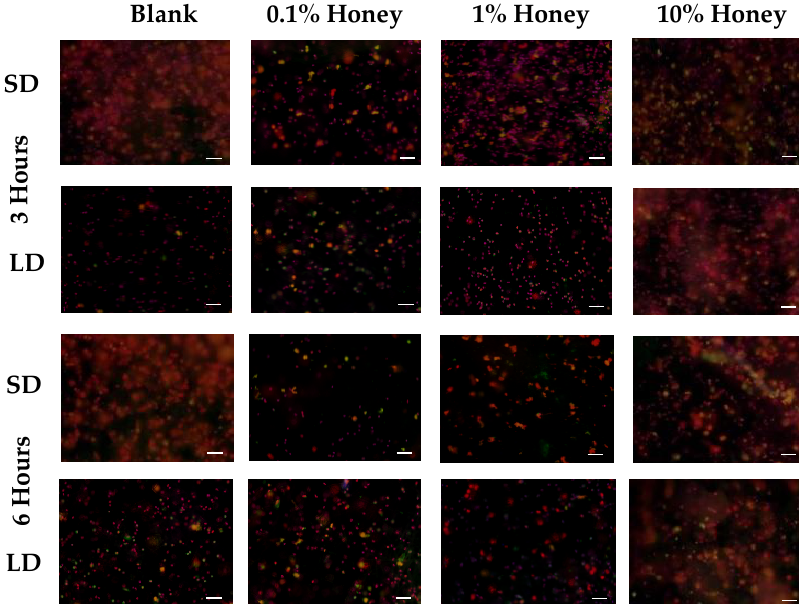
Figure 4. Representative fluorescence images of NETosis on LD and SD templates with 0%, 0.1%, 1%, and 10% honey at 3 and 6 h of culture, taken from experiment 1. Red indicates extracellular DNA (NETs), blue indicates intact nuclei, and green NE. Scale bar = 50 µm. Quantification is shown in Figure 5. Raw data is available in Supplementary Data Sheet 4, and single-channel images are available in Supplementary Document 2. Polymers 2020 , 12 , x FOR PEER REVIEW